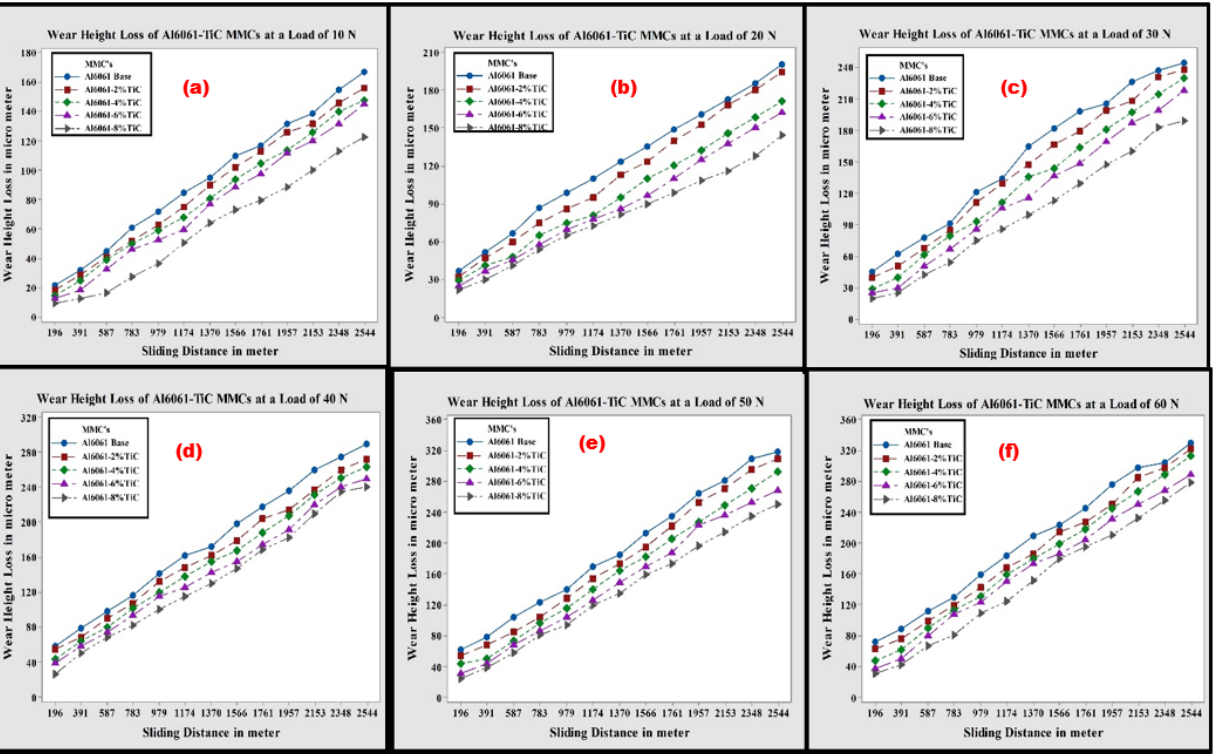
Figure 8. Wear height loss of Al6061 alloy and TiC MMCs, with a 2.5 km SD, at the loads of ( a ) 10 N; ( b ) 20 N; ( c ) 30 N; ( d ) 40 N; ( e ) 50 N; and ( f ) 60 N.